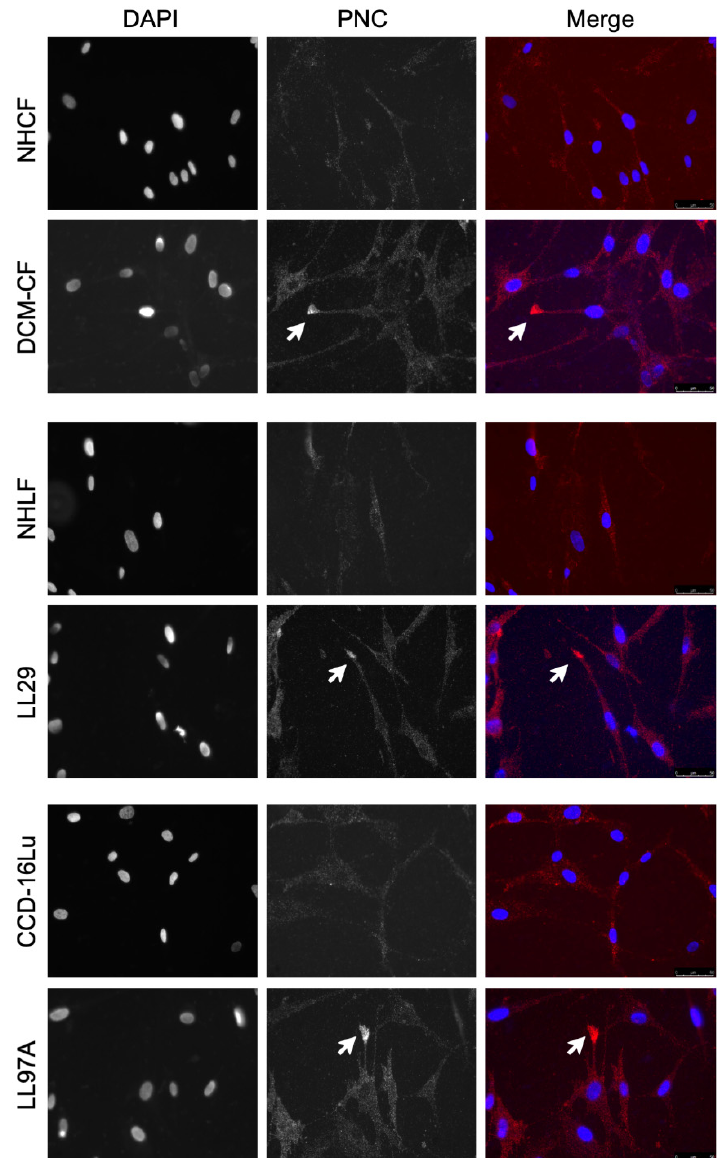
Figure 3. PNC is localized to cellular protrusions. Fixed, unpermeabilized myofibroblasts from fi- brotic and healthy tissues were immunostained for m- α -PNC mAb 10A10 (red) and DAPI (blue). PNC is localized to cellular protrusions on pathological myofibroblasts DCM-CF, LL29, and LL97A (arrows). PNC is not expressed on the surface of NHCF, NHLF, or CCD-16Lu isolated from healthy donor.